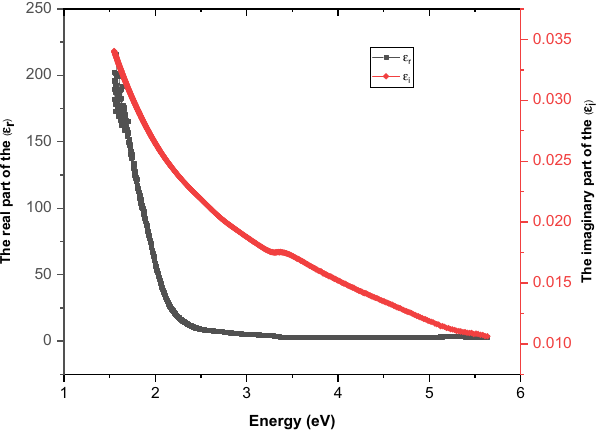
Figure 7. Variation of real and imaginary parts of the dielectric constant with incident photon energy ( hν ).